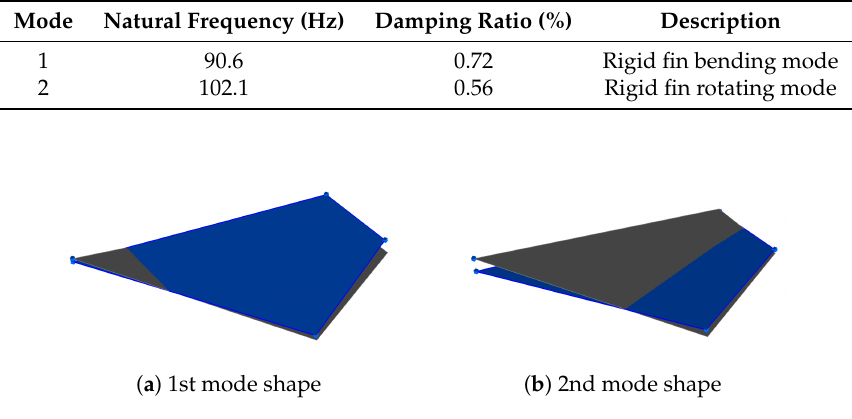
Figure 5. The first 2 mode shapes of all movable